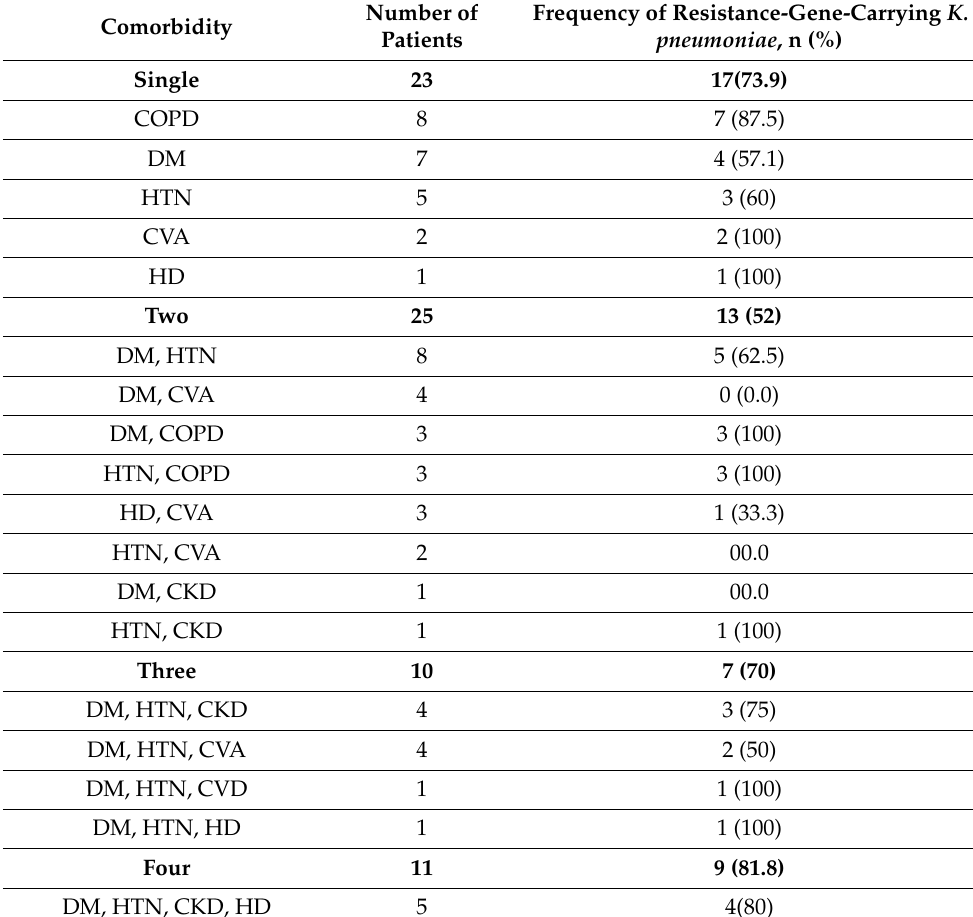
Table 3. Distribution of resistance-gene-carrying Klebsiella pneumoniae among studied patients based on the number of comorbidities.